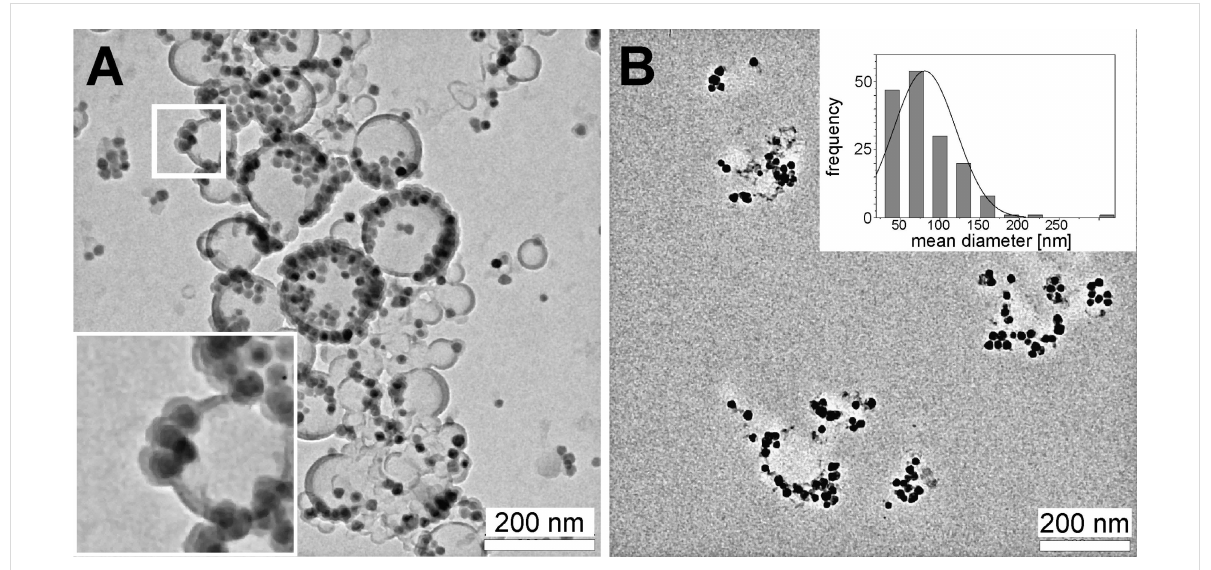
Figure 3: TEM bright field micrographs of a dispersion of magnetite-decorated PLLA nanoparticles prepared by drop casting and subsequent carbon evaporation (A) and by high pressure freezing (HPF) followed by freeze substitution and microtomy (B). The inset of B shows the distribution of PLLA nanoparticle diameters as determined from 164 individual particles after HPF processing and TEM